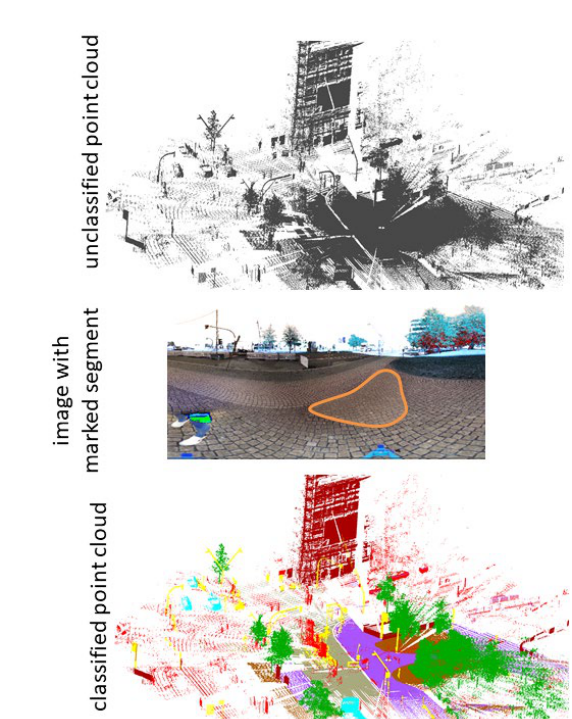
Figure 1. Basic idea of